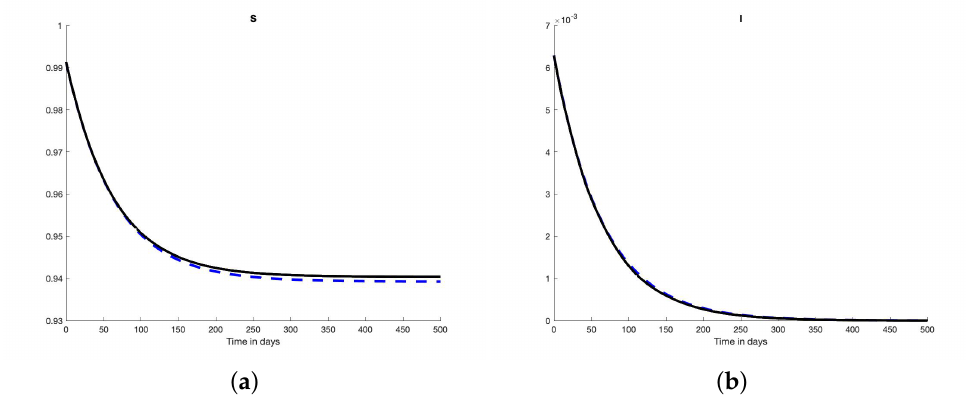
Figure 5. Scenario 3: Control. β , β ∗ (- -,blue), γ (- ., green) and β acceptable (- -, black).